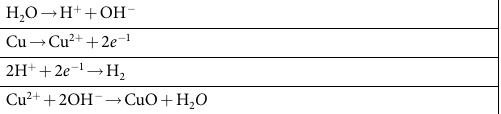
Table 1. Reactions on the anode.